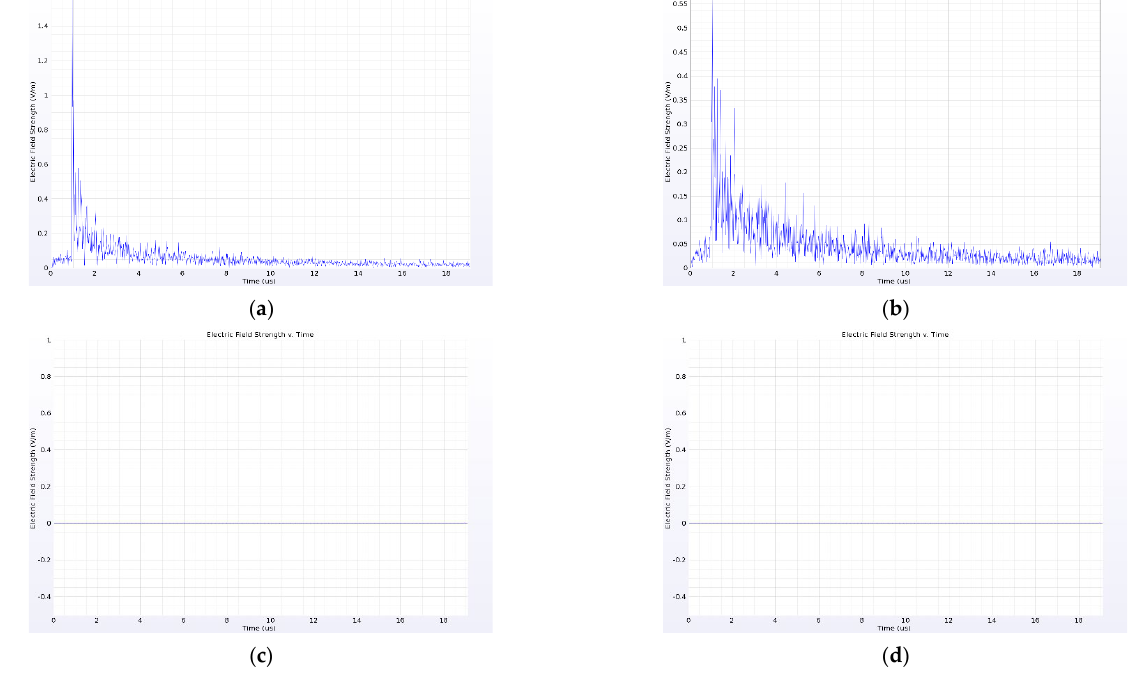
Figure 15. Effect of switchgear wall on near - field propagation characteristics of PD electromagnetic wave signal. ( a ) Electric field strength at point sensor 1; ( b ) Electric field strength at point sensor 2; ( c ) Electric field strength at point sensor 3; ( d ) Electric field strength at point sensor 4.